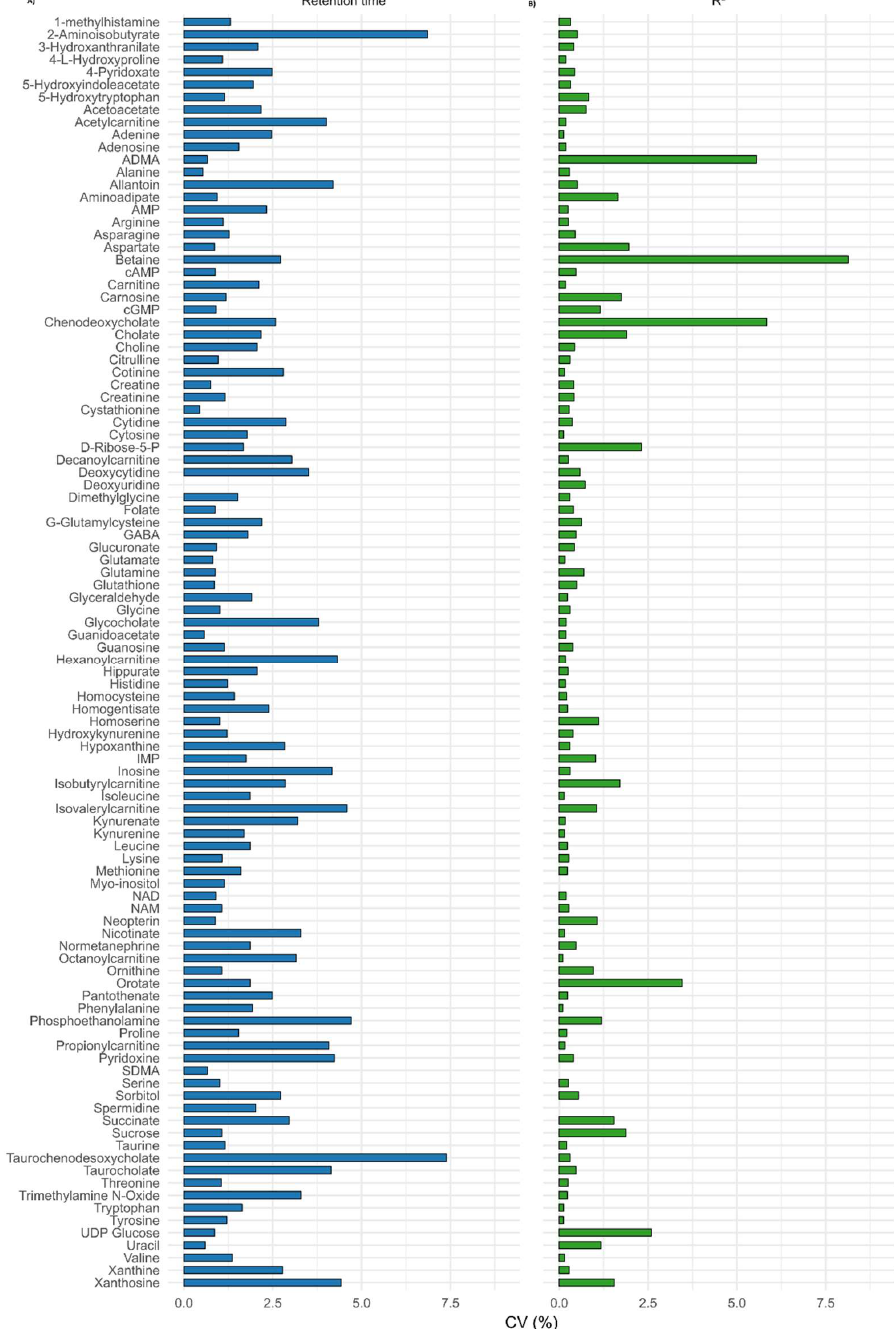
Figure 7. Reproducibility of ( A ) retention time of respective chromatographic peaks and ( B ) regression coefficient values (R 2 ) from external calibration curve standards for each metabolite analyzed in 25 different batches over a period of 1 year.